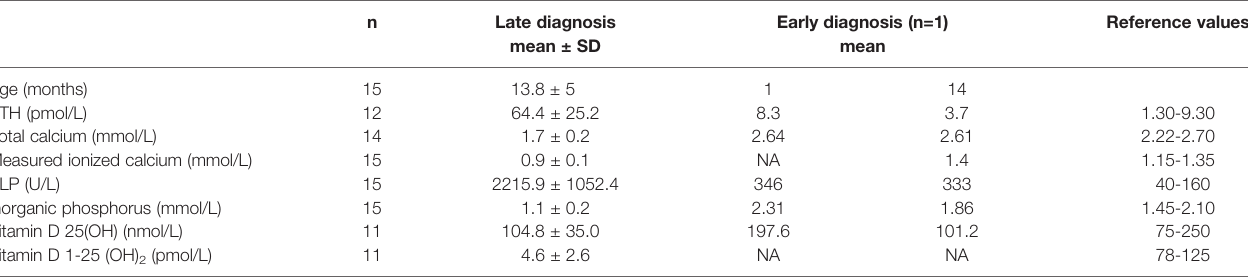
TABLE 6 | Metabolic bone blood pro fi le of affected individuals at the time of late and early diagnosis.